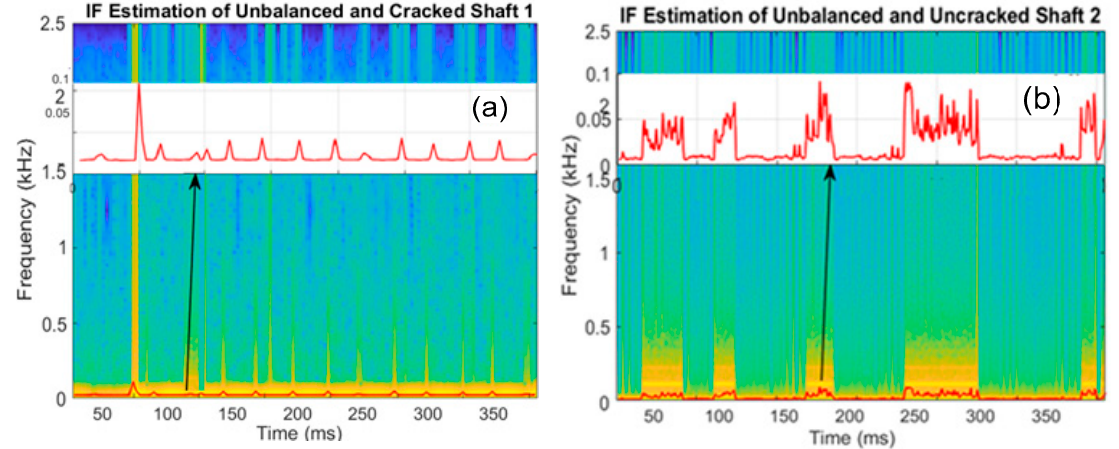
Appl. Sci. 2021 , 11 , x FOR PEER REVIEW Figure 11. Experimental instantaneous frequency of ( a ) cracked unbalanced driveshaft, ( b ) unbalanced driven shaft.